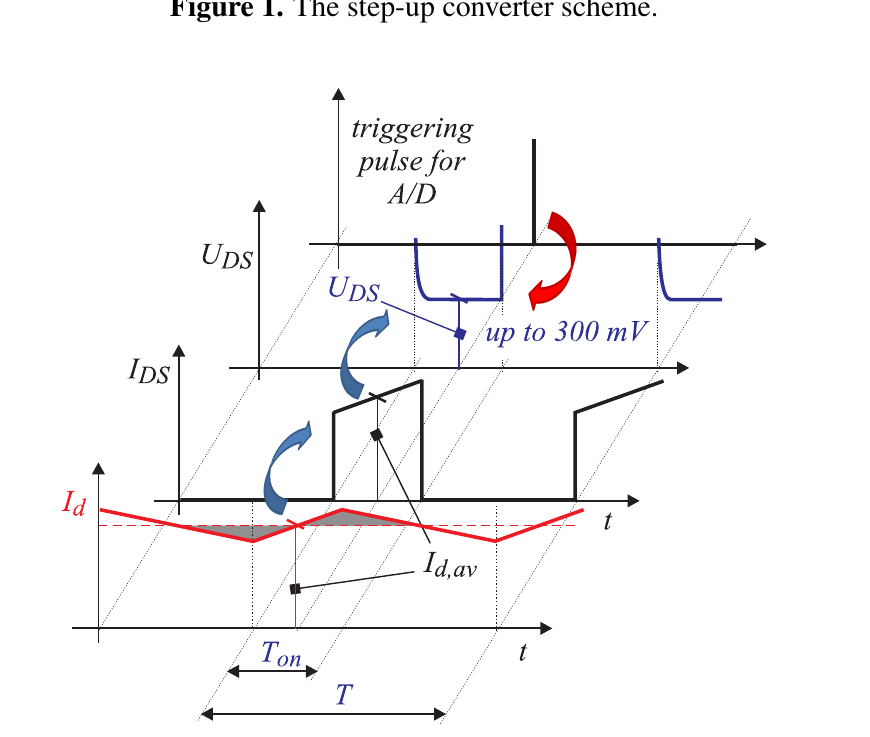
Figure 2. Synchronization of the U